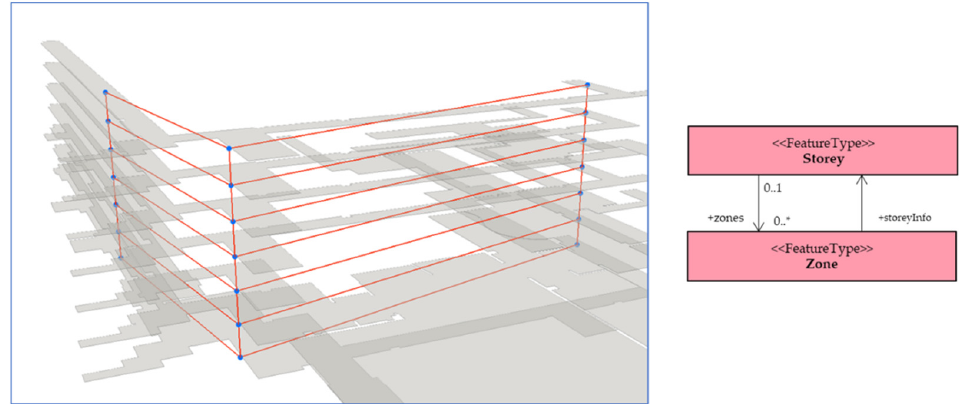
Figure 13. Level 2 network data representing zones per floor level.